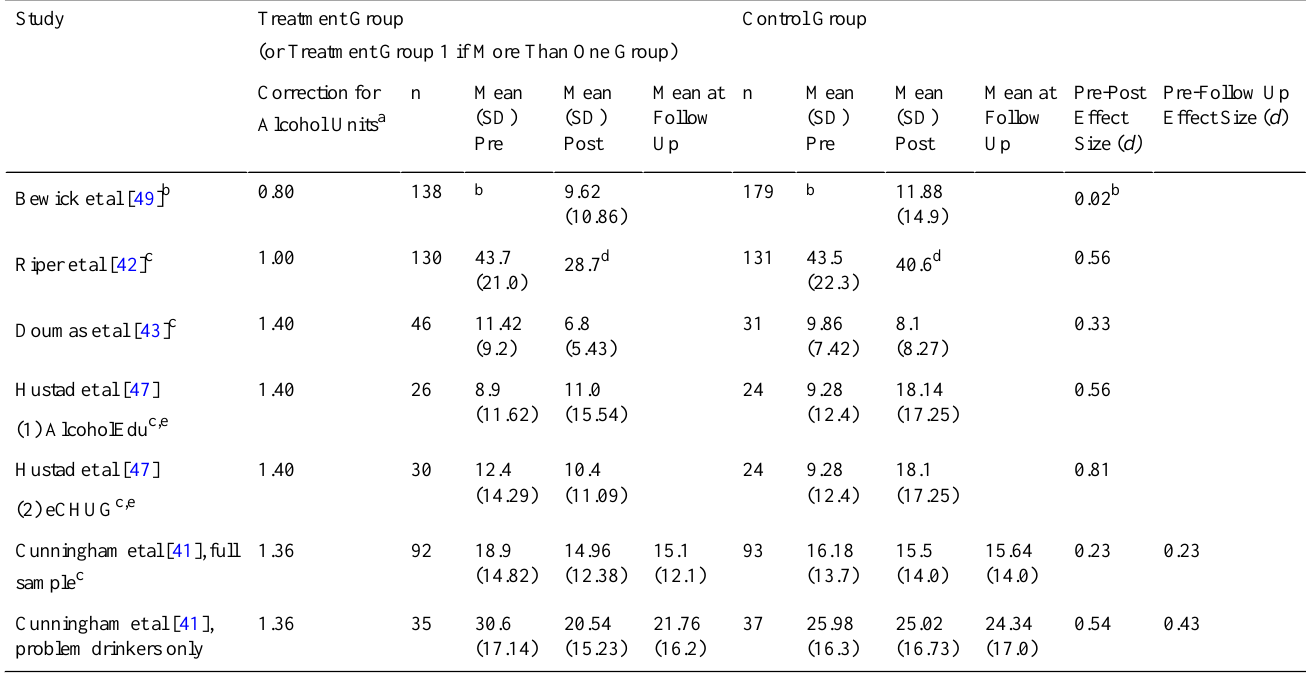
Table 2. Randomized controlled trials of online alcohol interventions